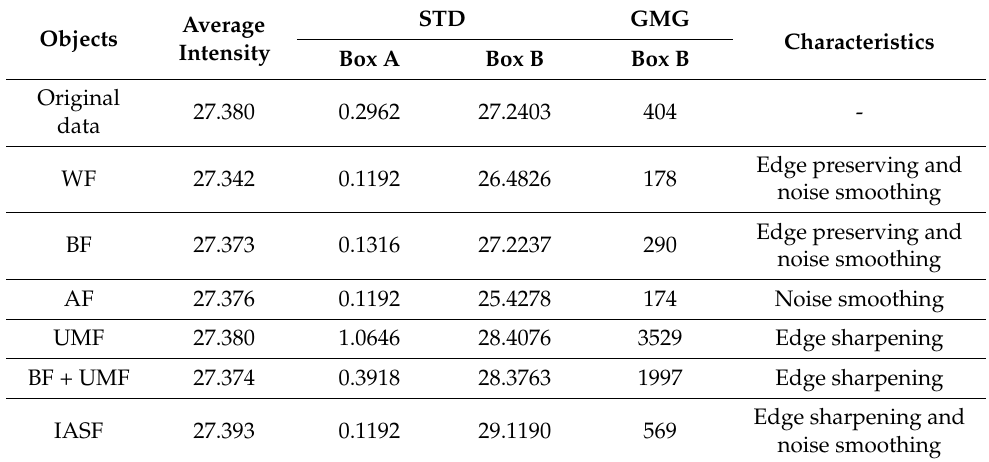
Table 2. The comparison results for image data of target